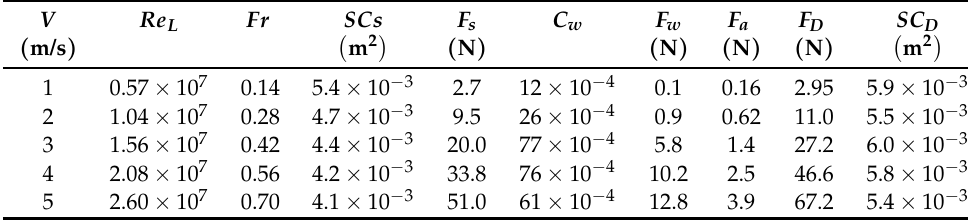
Table A1. Evolution of the different drag contributions with the boat velocity estimated using the parameters associated with Athlete A1: L = 5.2 m, w = 0.41 m, H = 1.70 m and M t = 76